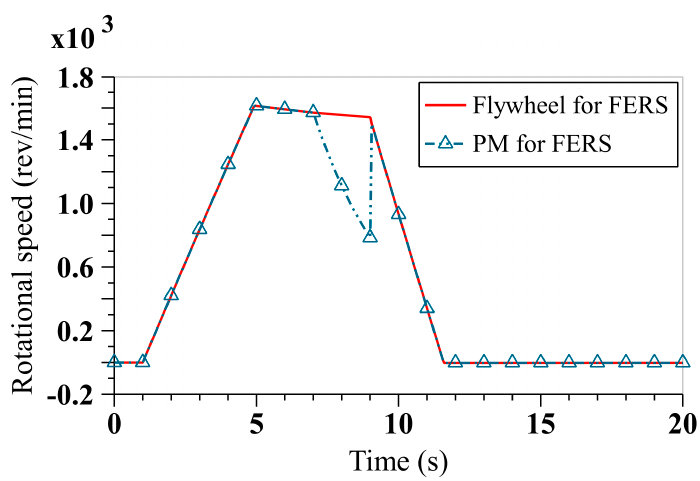
Figure 15. The rotational speeds of the flywheel and PM of FERS.